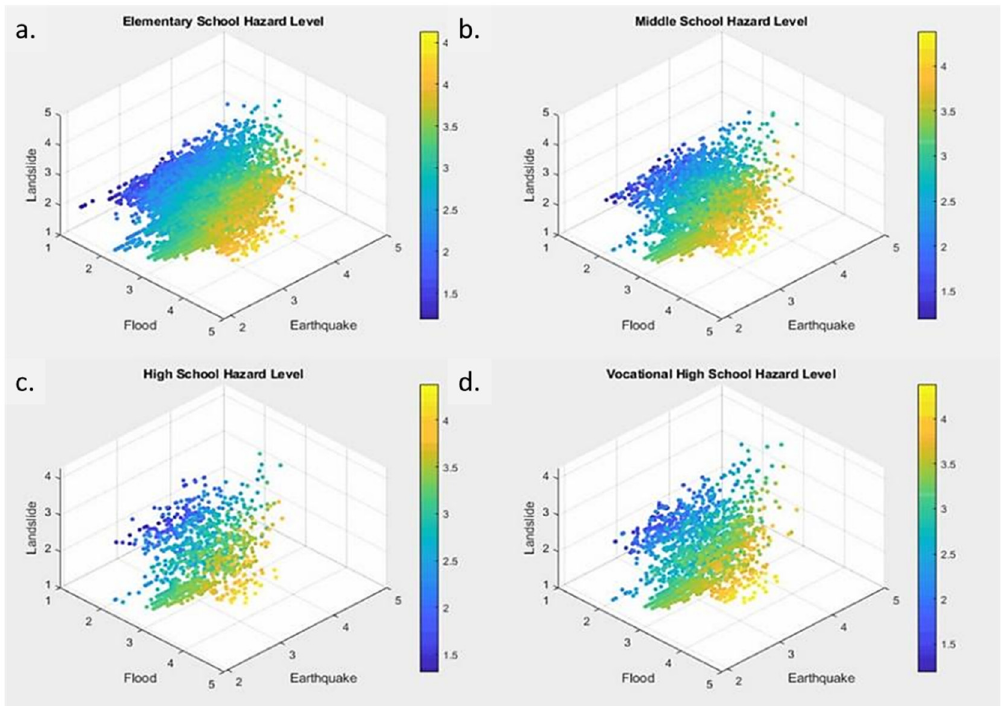
Figure 9. School hazard level for: ( a ) elementary, ( b ) junior high, ( c ) senior high, and ( d ) vocational high schools.